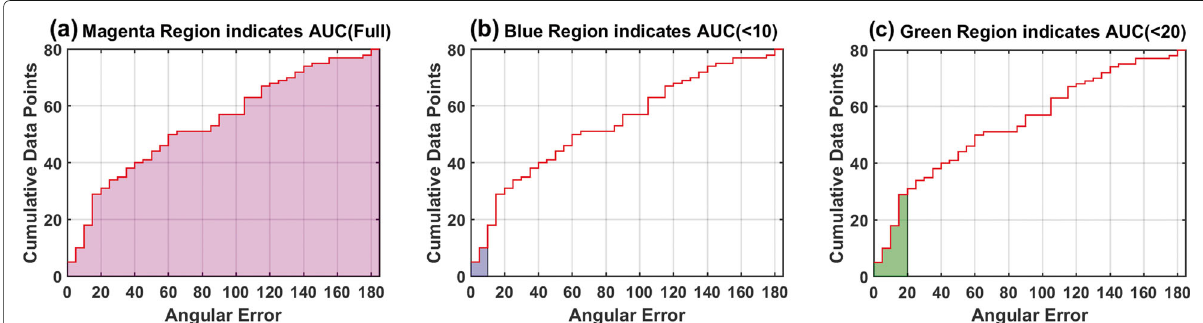
Fig. 7 Typical cumulative histograms and the shaded area in each subplot is the AUC. The normalized AUC is obtained by dividing the shaded area by the total area of the rectangular box. In these plots, the x -axis indicates the angular value and y -axis indicates the cumulative number of data points. Fractional AUCs are calculated and referred to as AUC( < δ ), indicating the area under the curve from angular deviation = 0 to angular deviation = δ . For example, the AUC, AUC( < 10), and AUC( < 20) are shown in a , b , and